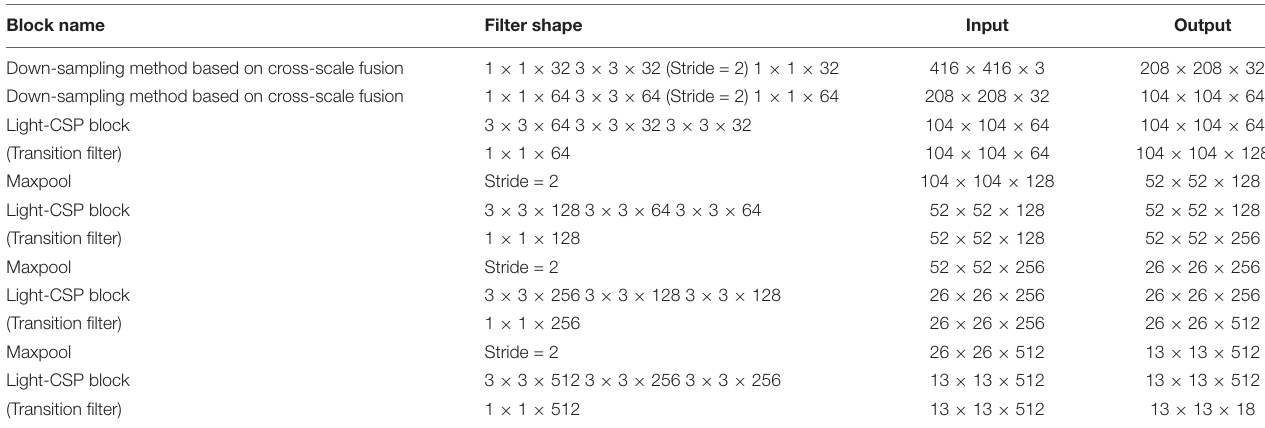
FIGURE 5 | Network structure of down-sampling method based on cross-scale fusion function. TABLE 1 | Internal parameters of the network architecture of